Question: What visual encoding does this figure use to show its data?
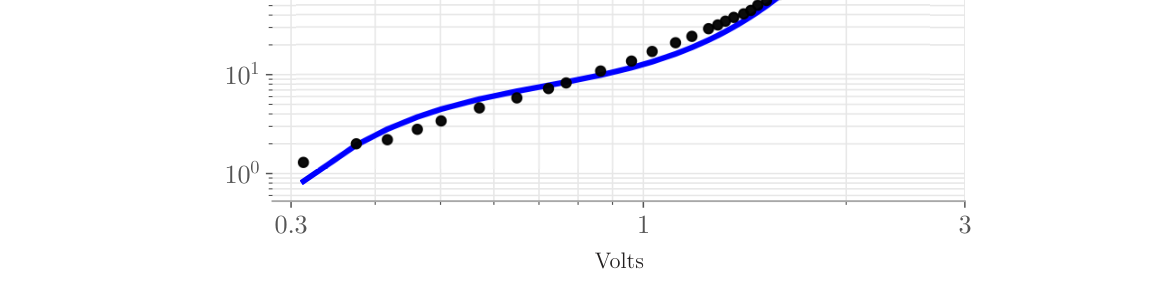
Answer: line